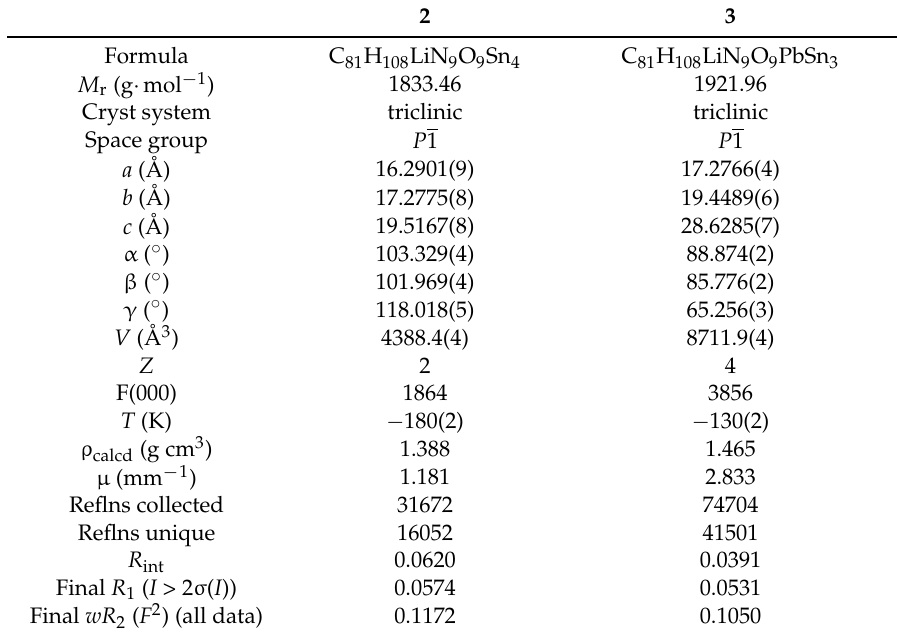
Figure S1: Molecular structure of compound 4 . Table S1: Crystallographic data for compound 4 . Figures S2–S7 contain the graphical representations of recorded NMR